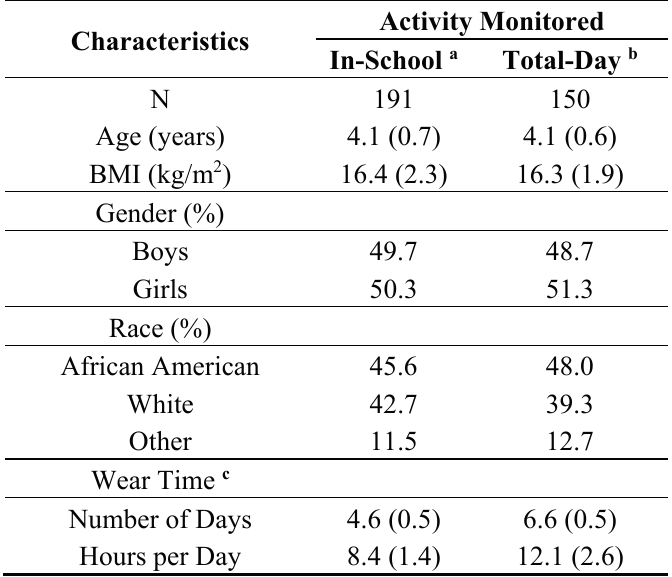
Table 1. Characteristics of Participants by Activity Monitored, Mean (SD) or